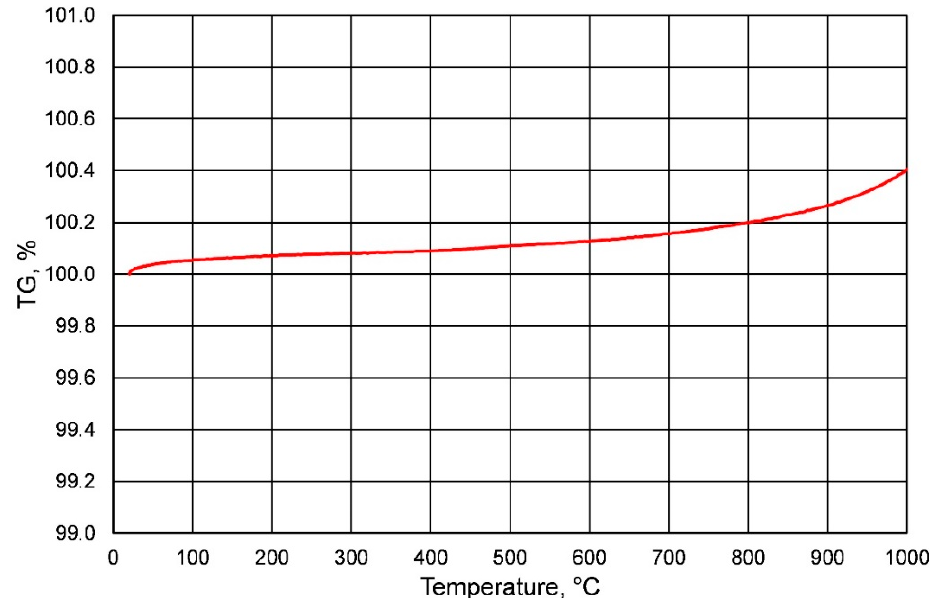
Figure 14. Thermal analysis of the P100 sand matrix.